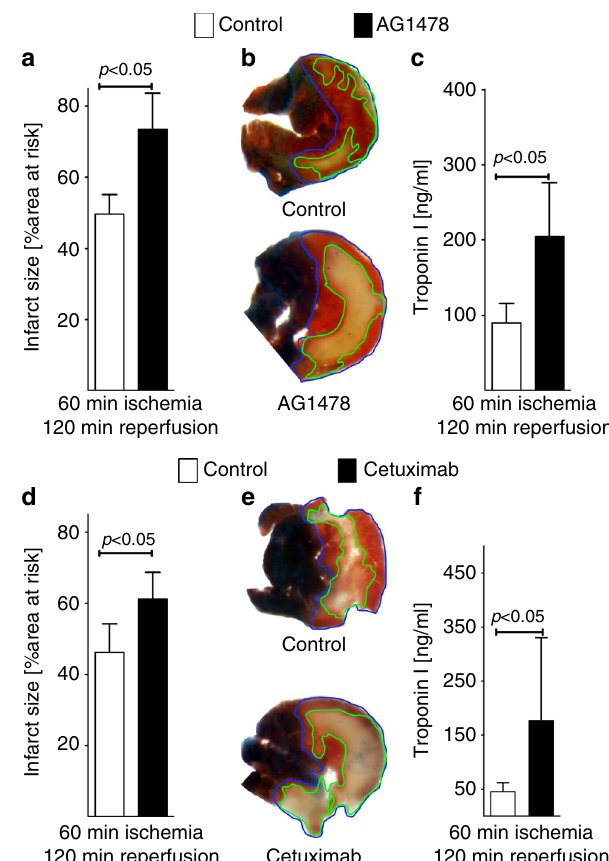
Fig. 6 Pharmacologic inhibition of the amphiregulin receptor ErbB1 during murine myocardial ischemia – reperfusion injury. a – c Mice underwent 60 min of myocardial ischemia, followed by 120 min of reperfusion; infarct sizes were measured by double staining with Evan ’ s blue and triphenyltetrazolium chloride and serum samples were collected. All infarct sizes are presented as the percentage of infarcted tissue in relation to the area-at-risk. Serum Troponin levels were determined by ELISA. a Infarct sizes of C57/BL6 mice after 60 min of ischemia and 120 min reperfusion, treated prior to myocardial ischemia reperfusion with vehicle or an ERBB1- speci fi c inhibitor (AG1478), administered 15 min prior to ischemia via an indwelling arterial catheter. Data presented as the percentage of infarcted area in relation to area-at-risk ( n = 4 per group). b Representative infarct staining of C57/BL6 treated with vehicle or AG1478. c Troponin serum levels of C57/BL6 mice, after 60 min ischemia, 120 min reperfusion, treated with vehicle or AG1478 ( n = 5 per group). d Infarct sizes of C57/BL6 mice after 60 min of ischemia and 120 min reperfusion, treated 15 min prior to ischemia via an indwelling arterial catheter with vehicle or a highly speci fi c ERBB1-speci fi c inhibitor (Cetuximab). Data presented as the percentage of infarcted area in relation to area-at-risk (control n = 4; cetuximab n = 8). e Representative infarct staining of C57/BL6 treated with vehicle or Cetuximab. f Troponin serum levels of C57/BL6 mice after 60 min ischemia, 120 min reperfusion, treated with vehicle or Cetuximab ( n = 7 per group). All data in this fi gure is presented as mean ± SD. Statistical signi fi cance assessed by two-sided, unpaired Student ’ s t